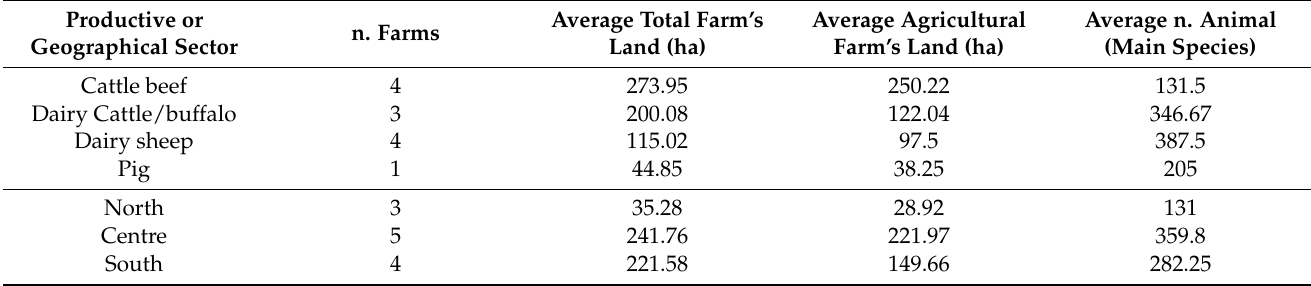
Table 3. Structural data of 12 farms divided by productive system and